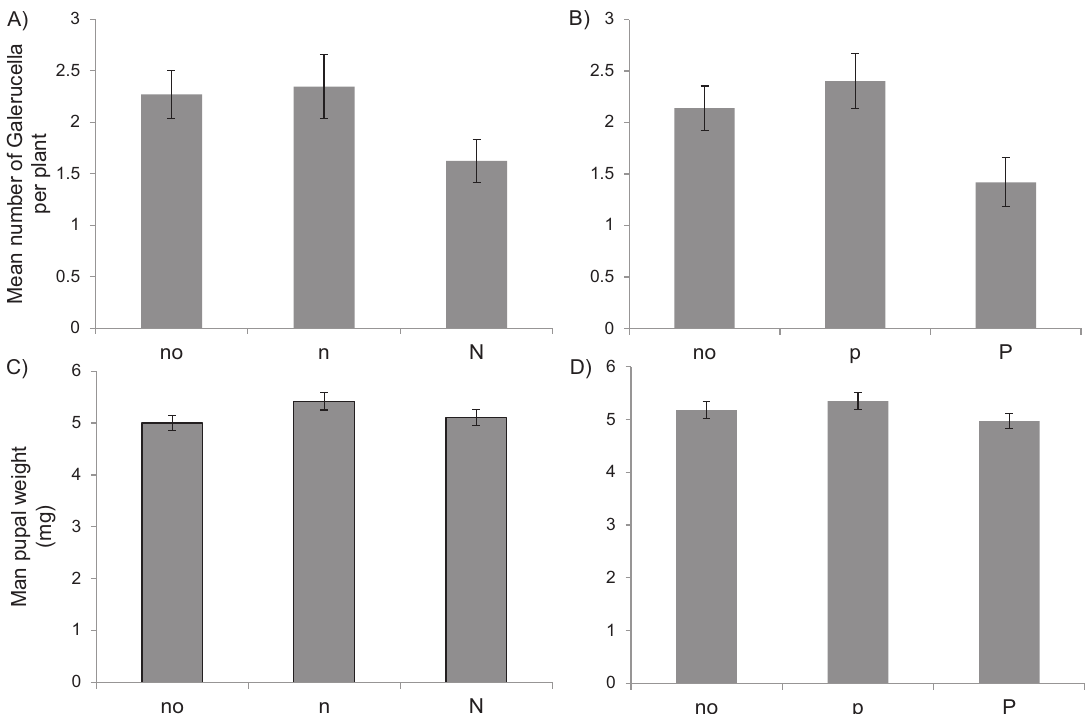
Figure 6. Mean number of Galerucella per L. salicaria plant ( A , B ) and mean pupal weight ( C , D ) in different fertilization treatments. No fertilization (no), medium (p) and high (N) nitrogen fertilization ( A , C ), and medium (n) and high (P) phosphate fertilization ( B , D